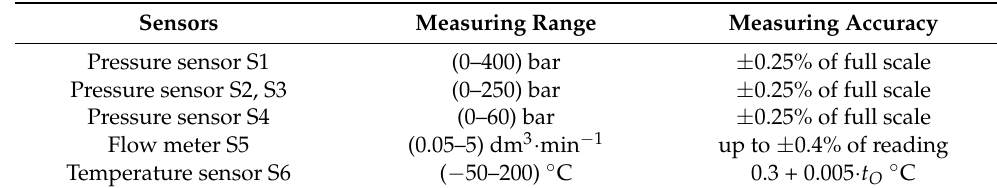
Figure 3. ( a ) Scheme of experimental equipment, ( b ) experimental equipment. Table 2. Technical parameters of used sensors.